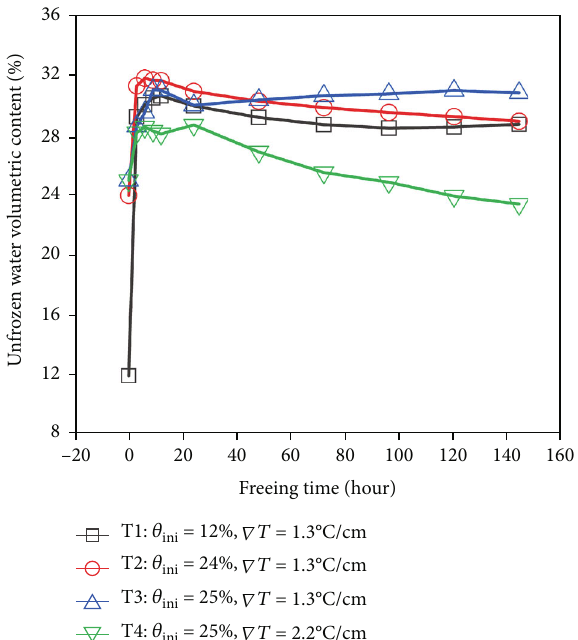
Figure 8: The average unfrozen water volumetric content changes of the soil